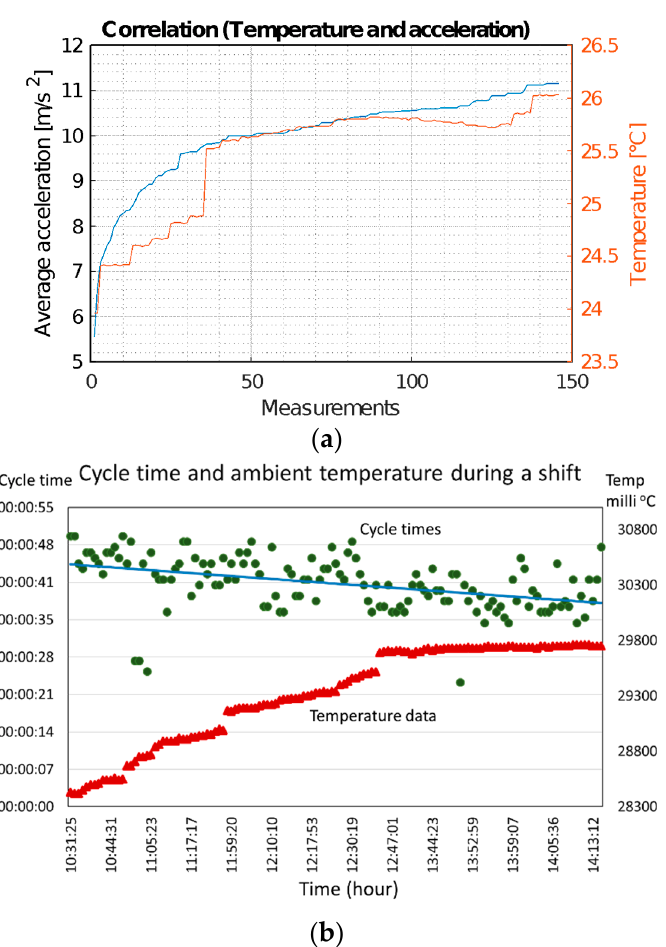
Figure 15. ( a ) Ambient temperature and maximum accelerations of the positioner. ( b ) Cycle time and temperature variations measured during a typical shift.